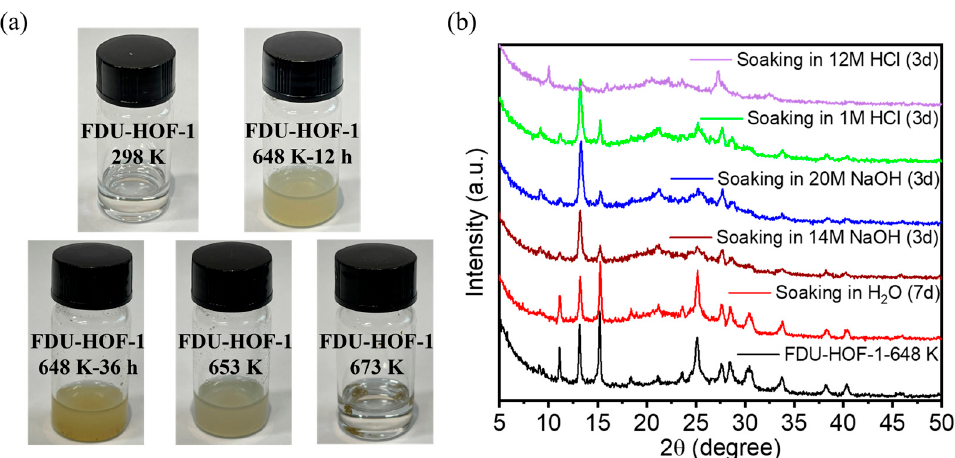
Figure 4. ( a ) Photographs of FDU-HOF-1 powder after being treated under different temperature conditions dissolved in DMF solution. ( b ) FDU-HOF-1-648 K-36h after soaking in different pH aqueous solutions for 3 days and soaking in water for 7 days.